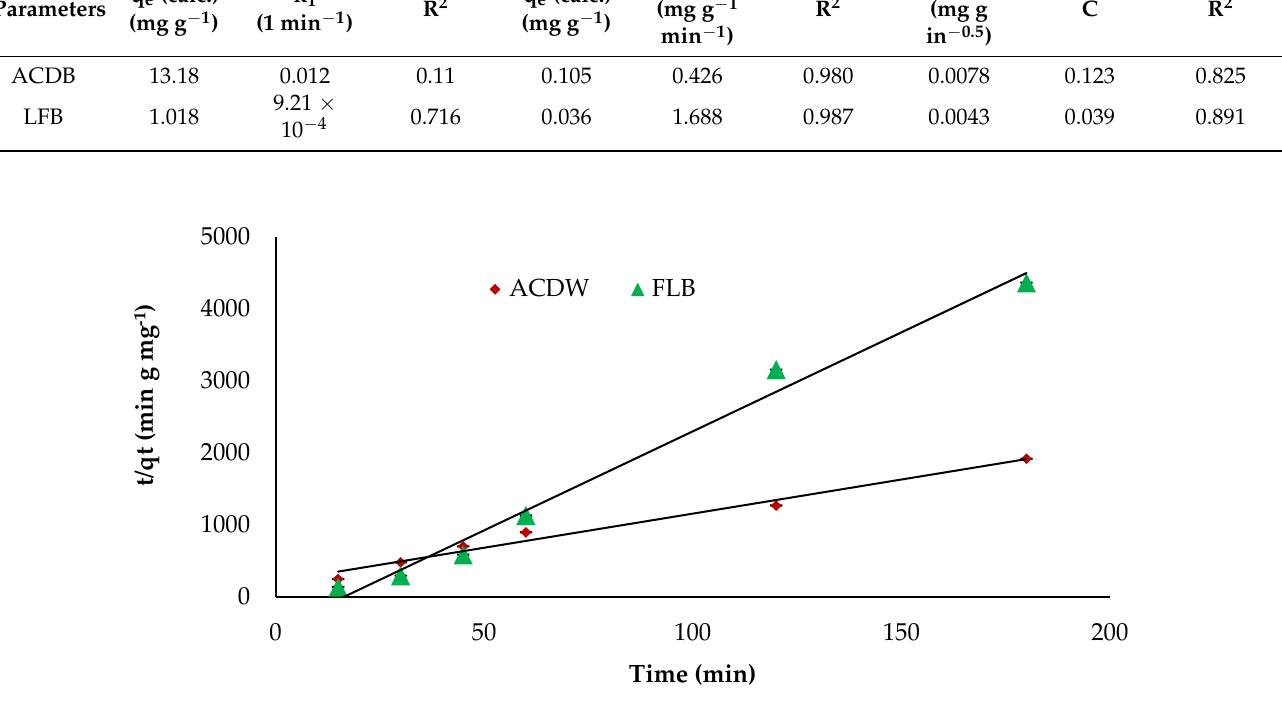
Figure 12. Pseudo-second kinetics of IV2R dyes onto ACDB and LFB.